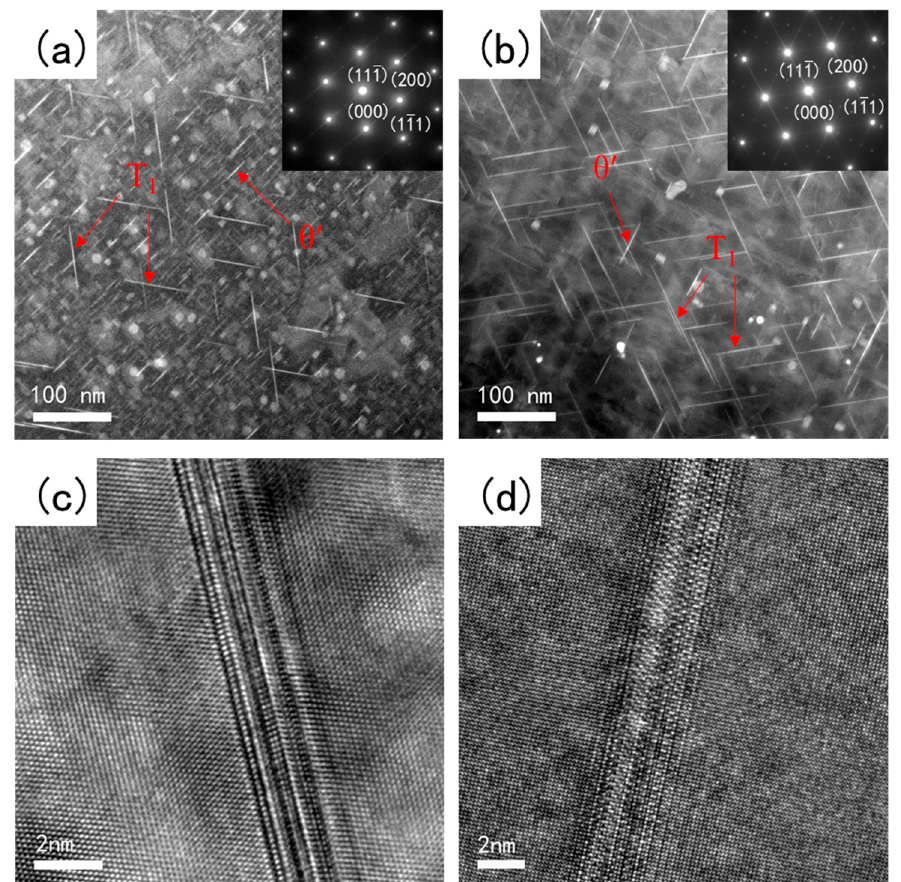
Figure 1. High angular annular dark field mode with scanning transmission electron microscopy (HAADF-STEM) images and corresponding diffraction patterns observed along the <110> zone axis after aging at 170 °C for ( a ) 8 h and ( b ) 20 h. ( c ) High-resolution transmission electron microscopy (HRTEM) image of the T1 phase observed along the <110> zone axis after aging at 170 °C for 20 h, and ( d ) HRTEM images of θ ' phase observed along the <001> zone axis after aging at 170 °C for 20 h.